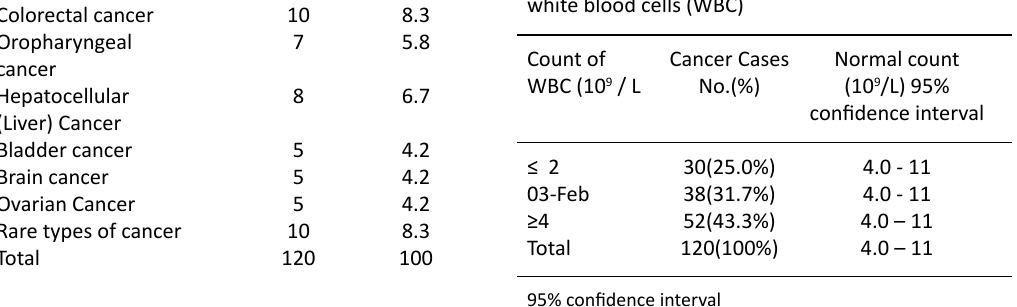
Table 4. Distribution of patients cancer by count